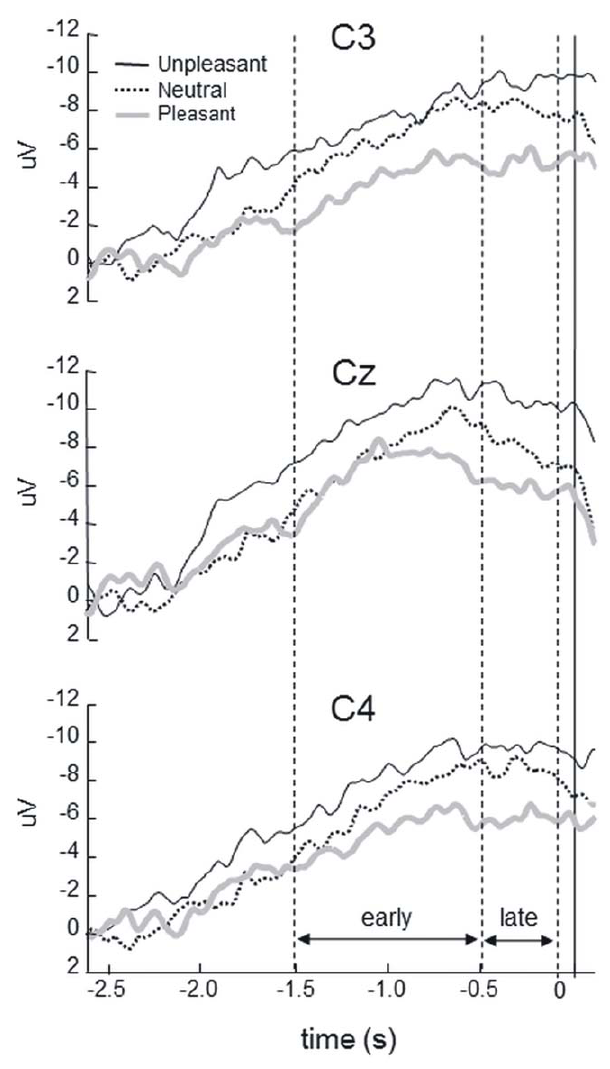
Figure 1. Mean average of readiness potential amplitudes preceding the grasping of pleasant, unpleasant and neutral stimuli for each analyzed channel (C3, CZ and C4). The mean readiness potential amplitude found for unpleasant stimulus was higher and that for pleasant stimuli lower relative to the observed for neutral stimuli.